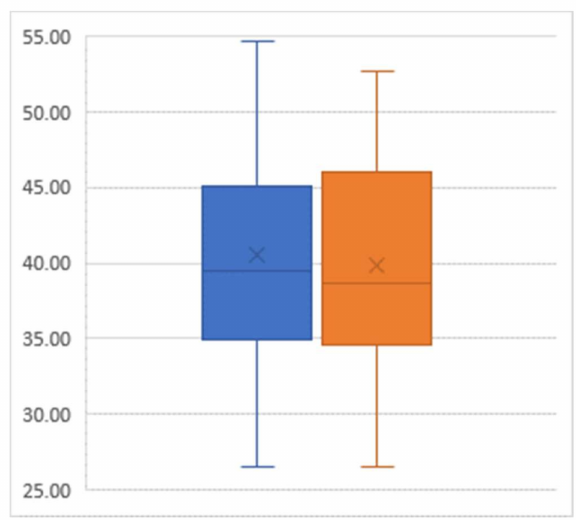
Figure 2. Box-and-whisker plot of body mass index (percent) pre-intervention (left) and post-intervention (right); Sample size =